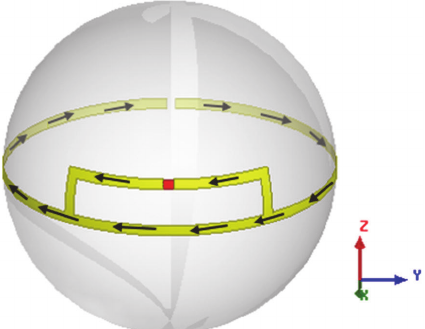
Figure 12: Current directions along the two arms of the 3D spherical antenna (Table 4).